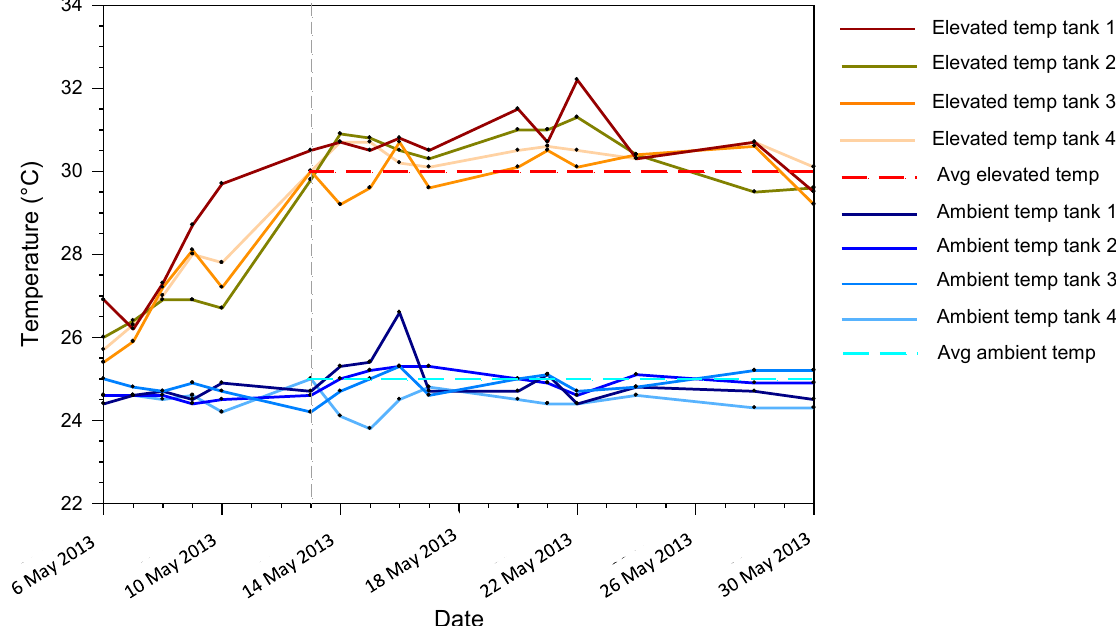
Figure 2. Temperature ( ◦ C) in each of the eight tanks over the duration of the study. The temperature ramp ended on Figure 2. Temperature (°C) in each of the eight tanks over the duration of the study. The temperature ramp ended on 13 Figure 2. Temperature (°C) in each of the eight tanks over the duration of the study. The temperature ramp ended on 13 Figure 2. Temperature (°C) in each of the eight tanks over the duration of the study. The temperature ramp ended on 13 Figure 2. Temperature (°C) in each of the eight tanks over the duration of the study. The temperature ramp ended on 13 Figure 2. Temperature (°C) in each of the eight tanks over the duration of the study. The temperature ramp ended on 13 May 2013 as indicated by the vertical dashed gray line. Average temperature of the four ambient temperature tanks was 13 May 2013 as indicated by the vertical dashed gray line. Average temperature of the four ambient temperature tanks May 2013 as indicated by the vertical dashed gray line. Average temperature of the four ambient temperature tanks was May 2013 as indicated by the vertical dashed gray line. Average temperature of the four ambient temperature tanks was May 2013 as indicated by the vertical dashed gray line. Average temperature of the four ambient temperature tanks was May 2013 as indicated by the vertical dashed gray line. Average temperature of the four ambient temperature tanks was 25 °C ± 0.5 (1SD), while average temperature for the elevated temperature tanks was 30 °C ± 0.6 (1SD). Average tempera- 25 °C ± 0.5 (1SD), while average temperature for the elevated temperature tanks was 30 °C ± 0.6 (1SD). Average tempera- 25 °C ± 0.5 (1SD), while average temperature for the elevated temperature tanks was 30 °C ± 0.6 (1SD). Average tempera- 25 °C ± 0.5 (1SD), while average temperature for the elevated temperature tanks was 30 °C ± 0.6 (1SD). Average tempera- was 25 ◦ C ± 0.5 (1SD), while average temperature for the elevated temperature tanks was 30 ◦ C ± 0.6 (1SD). Average 25 °C ± 0.5 (1SD), while average temperature for the elevated temperature tanks was 30 °C ± 0.6 (1SD). Average tempera- tures were calculated from the end of the ramping period on 13 May 2013 until the end of the experiment on 30 May 2013. tures were calculated from the end of the ramping period on 13 May 2013 until the end of the experiment on 30 May 2013. tures were calculated from the end of the ramping period on 13 May 2013 until the end of the experiment on 30 May 2013. tures were calculated from the end of the ramping period on 13 May 2013 until the end of the experiment on 30 May 2013. tures were calculated from the end of the ramping period on 13 May 2013 until the end of the experiment on 30 May 2013. temperatures were calculated from the end of the ramping period on 13 May 2013 until the end of the experiment on 30 May